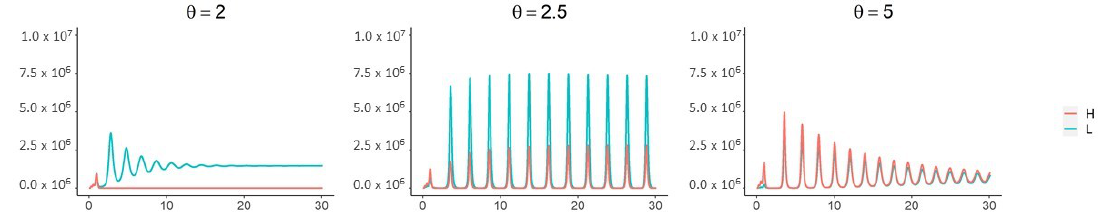
Figure 5. With all three mechanisms in place and children less susceptible to infection ( ν k = 1/2), a Hopf bifurcation occurs as θ passes through ∼ 2.3. For θ near 2.5, high-shedding cases return in greater numbers on a biennial cycle and eventually exceed their initial outbreak levels. The magnitude of outbreaks diminishes as θ increases past 2.5 but high-shedding infections make up a greater share of total infections in adults. Periodic solutions do not exist if children are more susceptible than adults ( ν k > 1). Vertical axes are the number of active infections in adults. Except for θ , all parameters as in Figure 4.